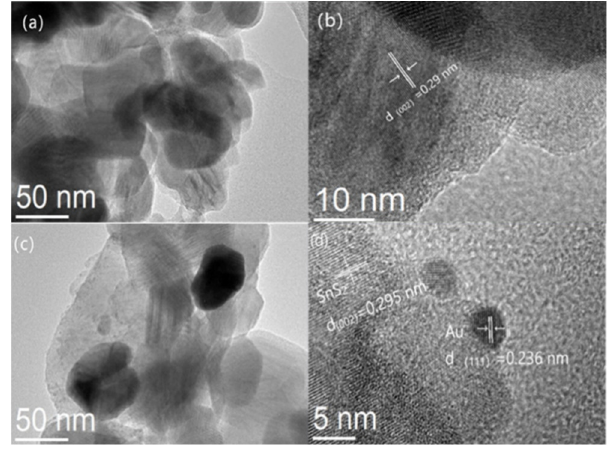
Figure 5. ( a ) TEM image of SnS 2 , ( b ) HRTEM image of SnS 2 , ( c ) TEM image of Au/SnS 2 -0.5, and ( d ) HRTEM image of Au/SnS 2 -0.5.